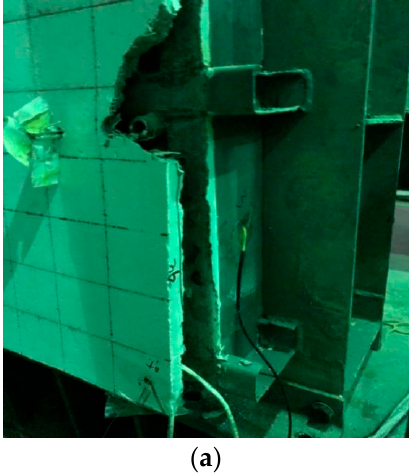
Figure 7. Loading protocol.